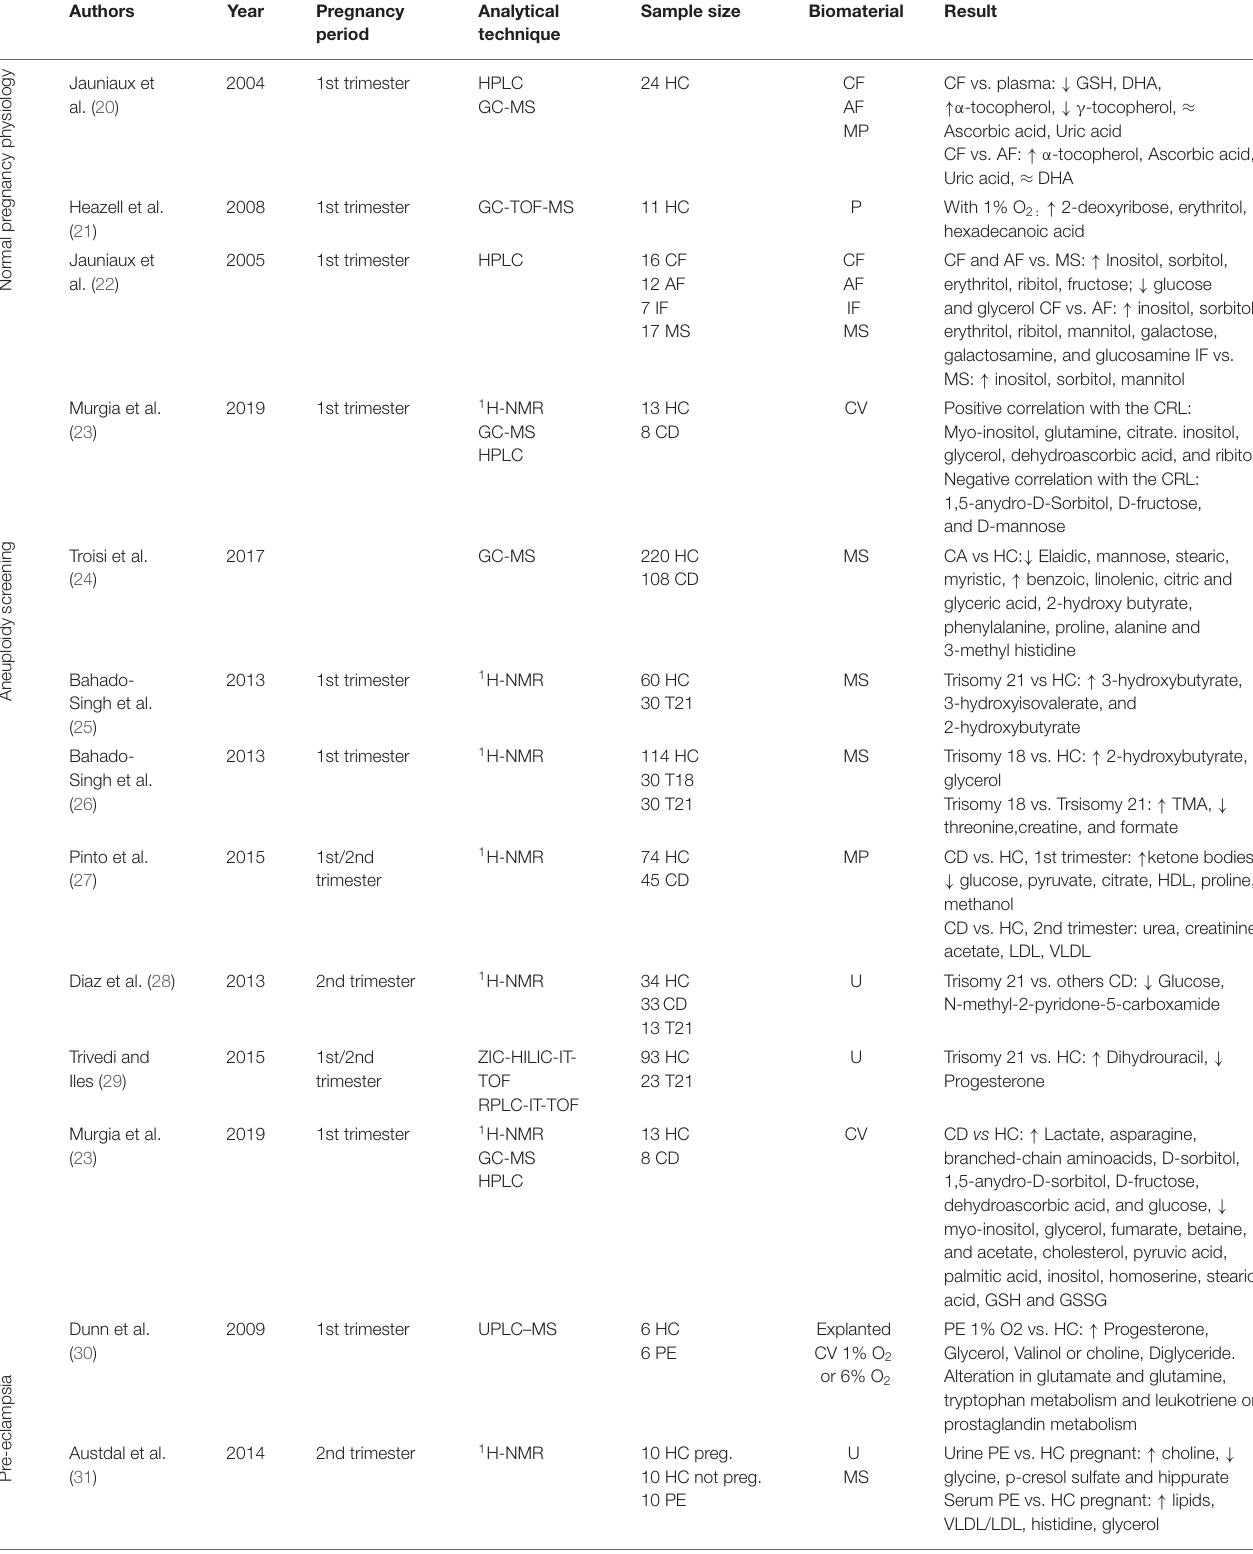
TABLE 2 | Key data points extracted from the cited studies. Authors Analytical